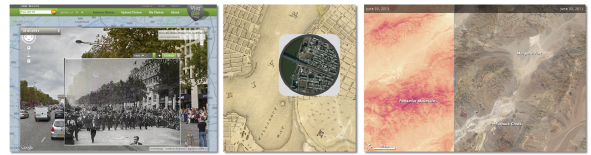
Figure 1: Co-visualizations of geographical